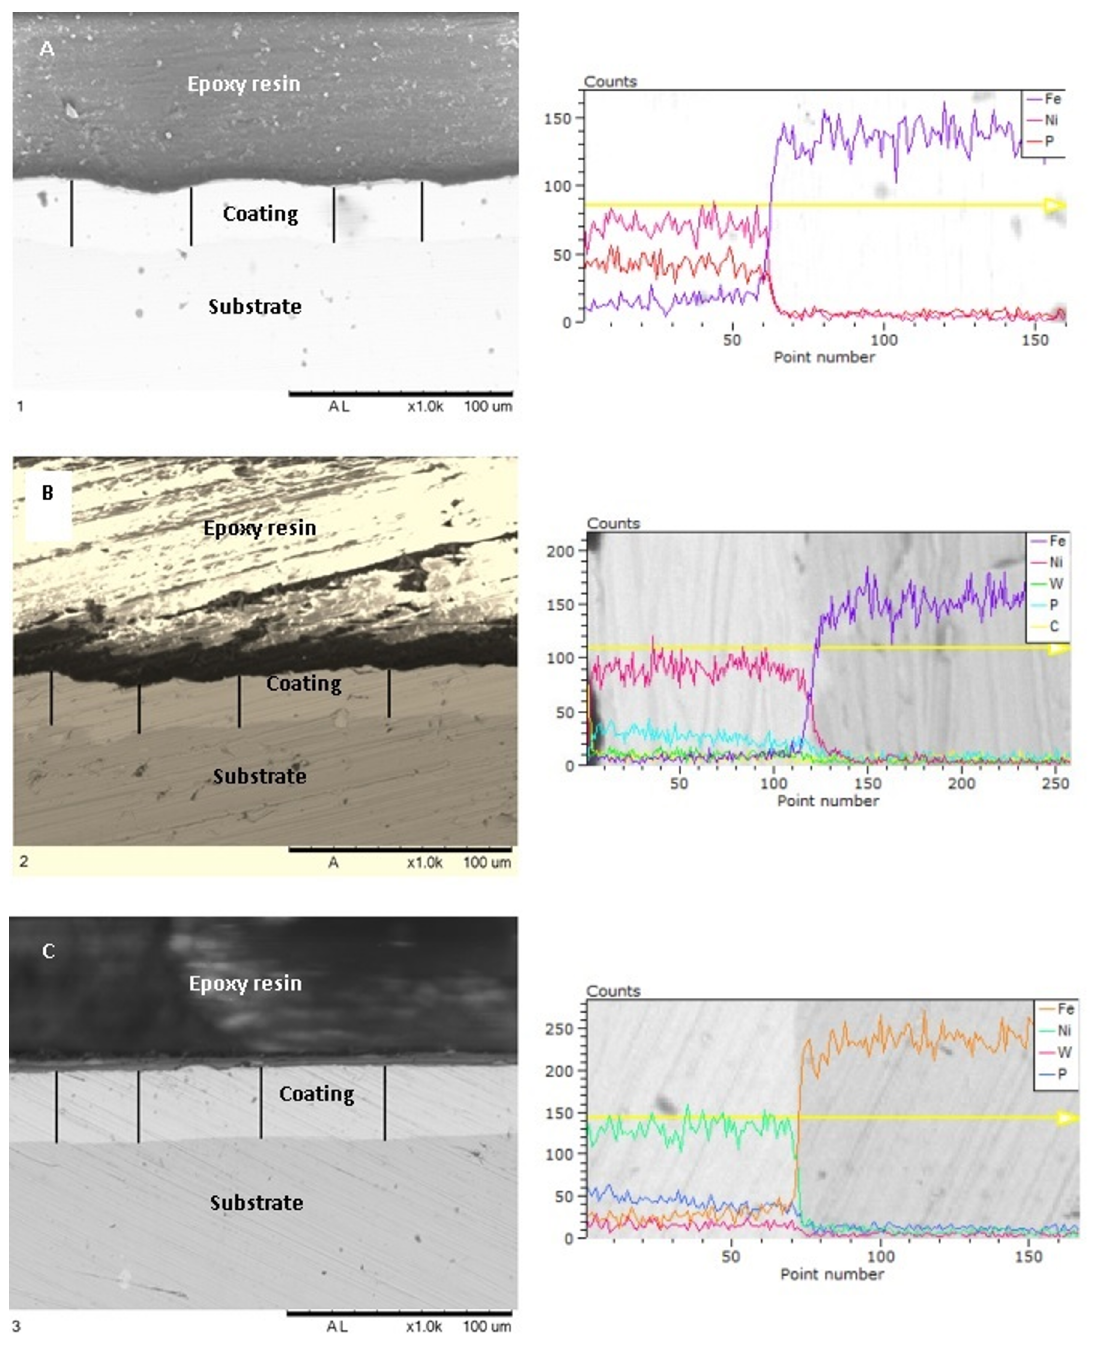
Figure 3. SEM micrographs of cross-sections of the coatings obtained in baths with different tungsten concentrations: a) bath 1; b) bath 2; c) bath 3. The corresponding EDS linescans are shown at